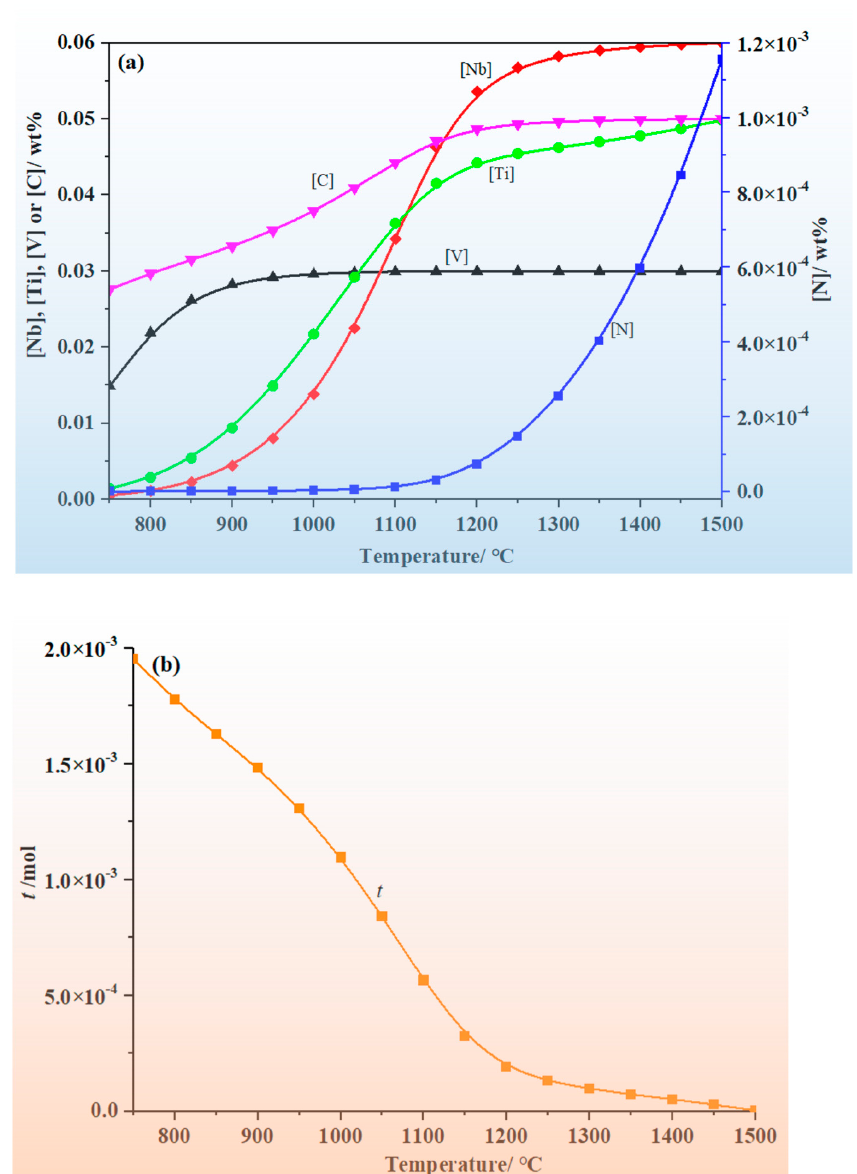
Figure 10. Change in the solid-dissolved contents ( a ) and total molar fraction of the secondary phases ( b ) with temperature T obtained from the thermodynamic analysis of N1 steel.